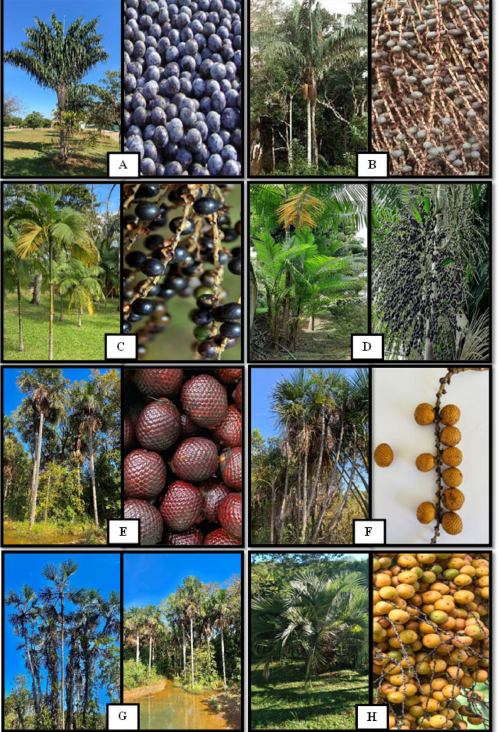
Figure 2. Arecaceae palm trees and their fruits: ( A ) bacaba ( Oenocarpus bacaba ), ( B ) patawa ( Oenocarpus bataua ), ( C ) juçara ( Euterpe edulis ), ( D ) aça í ( Euterpe oleracea ), ( E ) buriti ( Mauritia flexuosa ), ( F ) buritirana ( Mauritiella armata , ( G ) similarity between buriti and buritirana, and ( H ) buti á ( Butia odorata) . Images: R ô mulo Alves